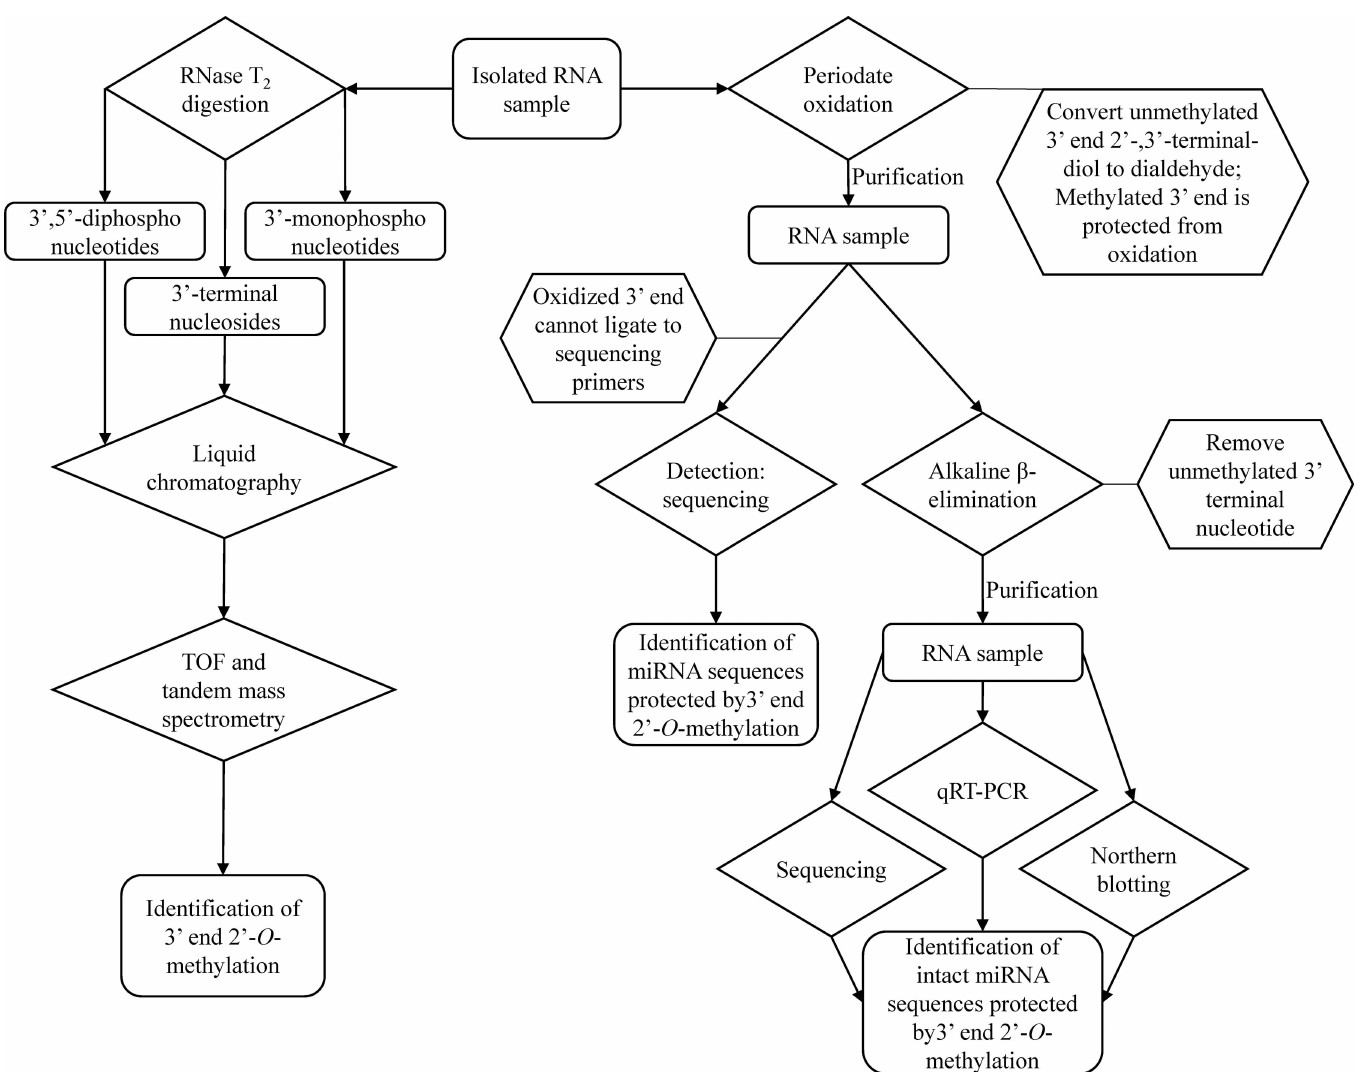
Fig 1. Methods of differentiating mature plant miRNAs from other miRNAs utilizing the 3’ end 2’-O-methylation.